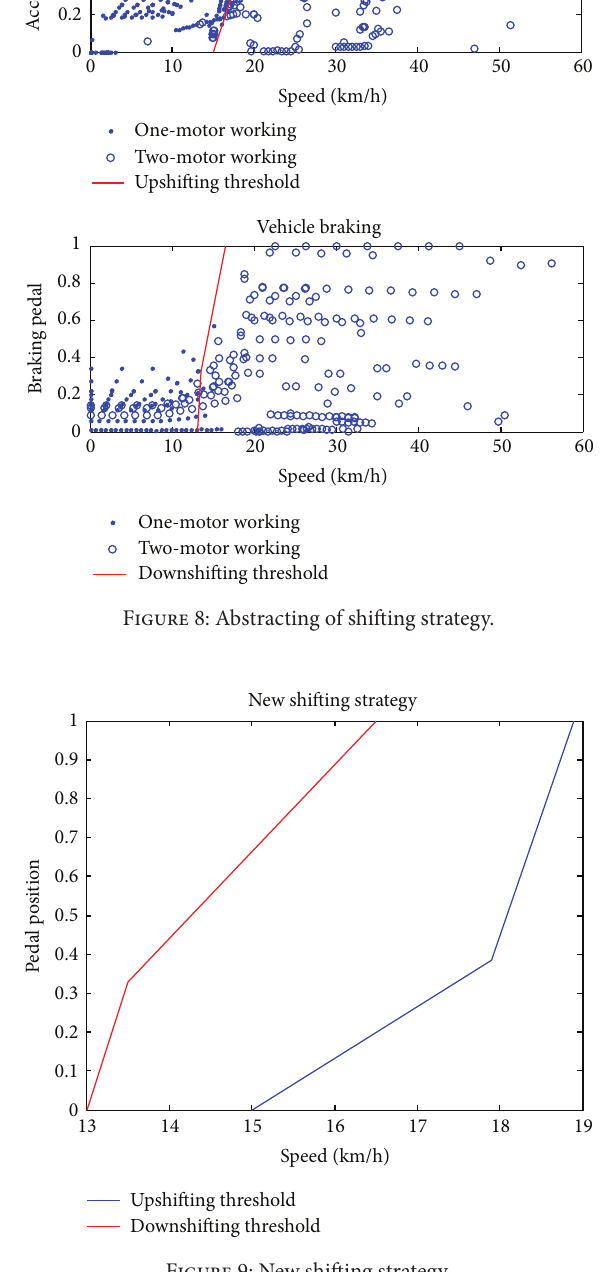
Figure 9: New shifting strategy.